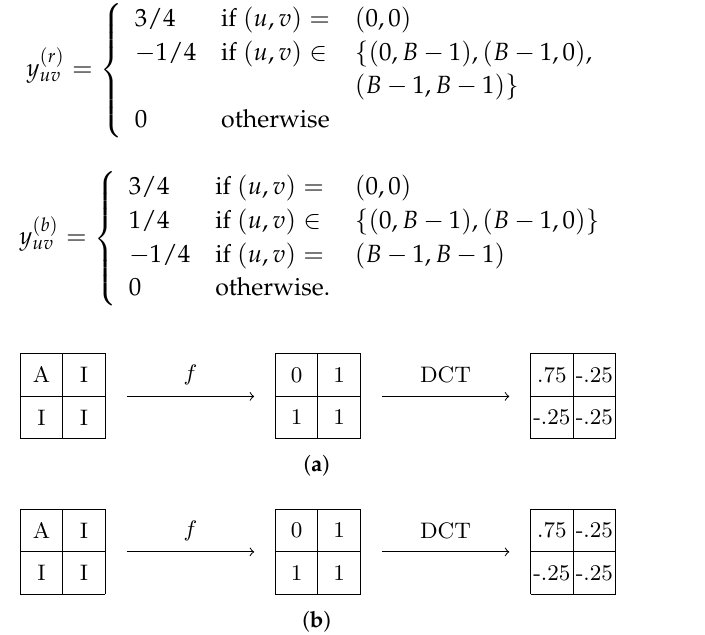
Figure 7. Resulting DCT ocefficients for 2 × 2 blocks of ( a ) red channel and ( b ) blue channel